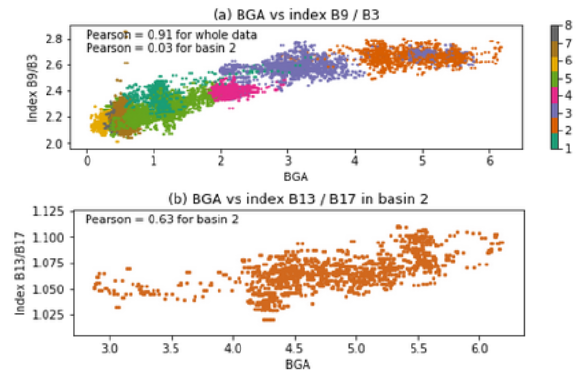
Figure 14. Scatter figures of the parameter BGA with the index B9 / B3 in the whole lake and B13 / B17 in basin 2 indices of the A/B-family which correlate best with BGA are lo- Figure 13. A-B-correlations for the parameters BGA and ODO cated in the neighborhood of the optimal index B9 / B3 and by in the whole data continuity are correlated also to each other. Considering the total structure of the figure instead of the correlation values, several re- gions of high correlation can be found. By choosing from each of these regions the index giving the local maximum of the correla- tion we obtain a set of indices with no built-in dependencies and from these indices the ones with low mutual correlations can be picked. Of course one can look for these non-correlating indices from several index families simultaneously. index B26 − B33 = R 743 − R 838 from the family A-B and the index B9 / B19 = R 567 / R 682 from the family A/B (correlations